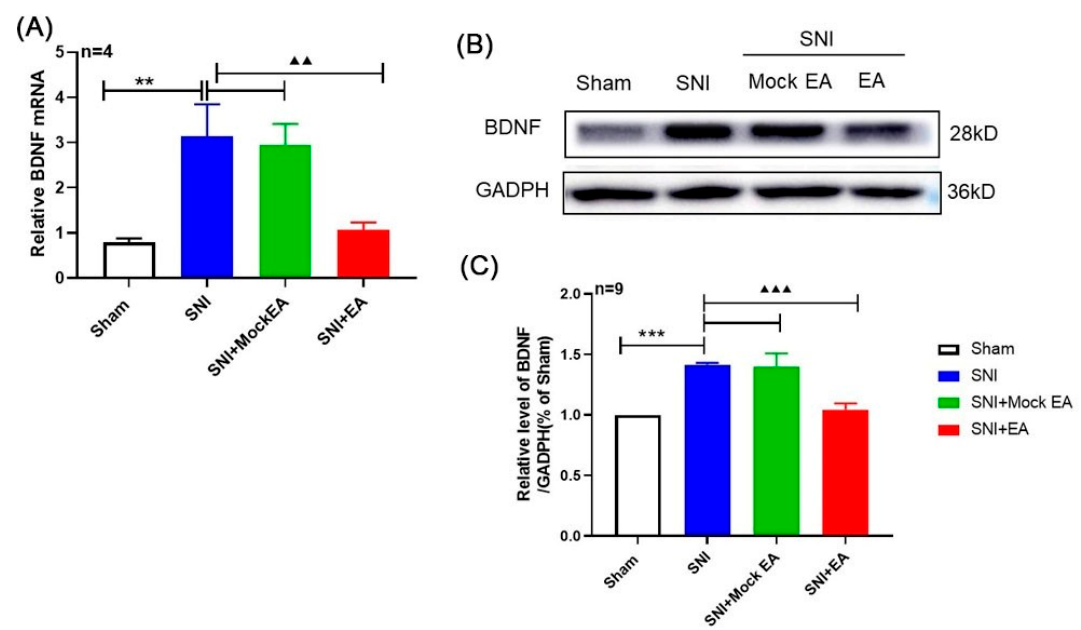
Figure 2. 2 Hz EA treatment reversed the SNI-induced up-regulation of brain-derived neurotrophic factor (BDNF) in the spinal cord. ( A ) Relative levels of BDNF mRNA expression ( n = 4 per group). ( B ) Western blotted band of BDNF. ( C ) The relative level of BDNF protein expression ( n = 9 per group). SNI increased BDNF protein expression in the spinal cord, which was attenuated by 2 Hz EA treatment. Samples were collected from the spinal cord of L4–L6 segments on day 14. ** p < 0.01, *** p < 0.001, compared with the Sham group. ▲▲ p < 0.01, ▲▲▲ p < 0.001, compared with the SNI group. All data were expressed as mean ± SEM, one-way ANOVA was followed by the Newman–Keuls post-hoc